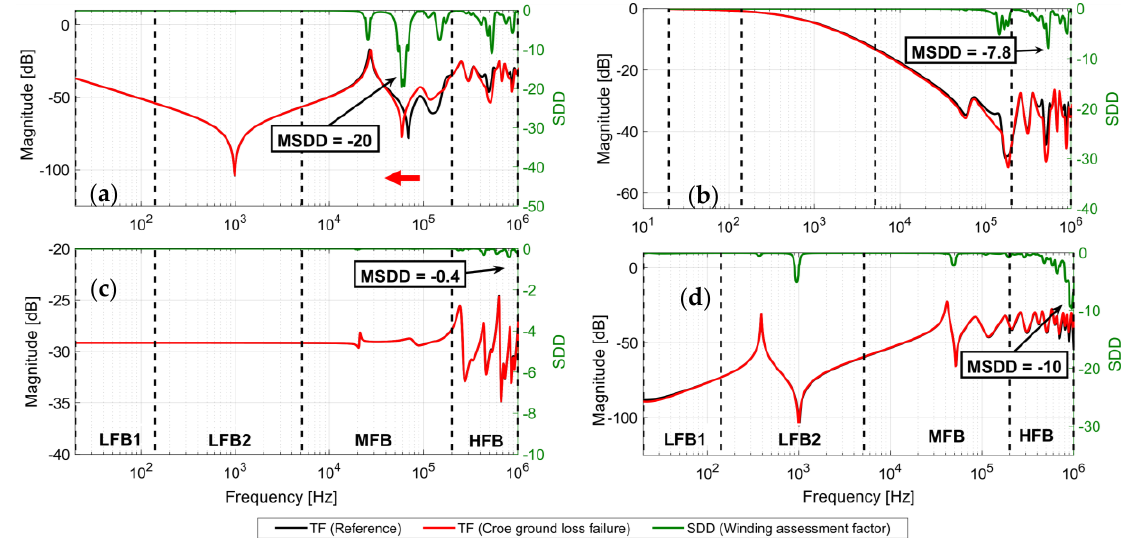
Figure 26. TFs of B-phase HV winding with and without core ground (vector group YNyn0) and SDD as a measure of deviation between TFs; ( a ) HV-OC, ( b ) HV-SC, ( c ) IIW, ( d ) CIW.